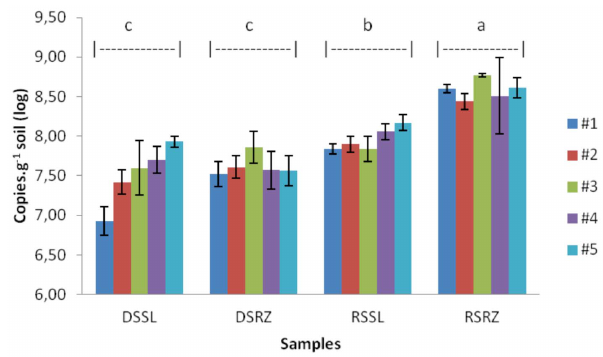
Figure 2. Quantification by qPCR of bacterial 16S rRNA gene copies in samples obtained during the rainy (RS) and dry (DS) seasons for both bulk soil (SL) and rhizosphere (RZ). Values indicate the average of three replications, and bars represent standard errors.